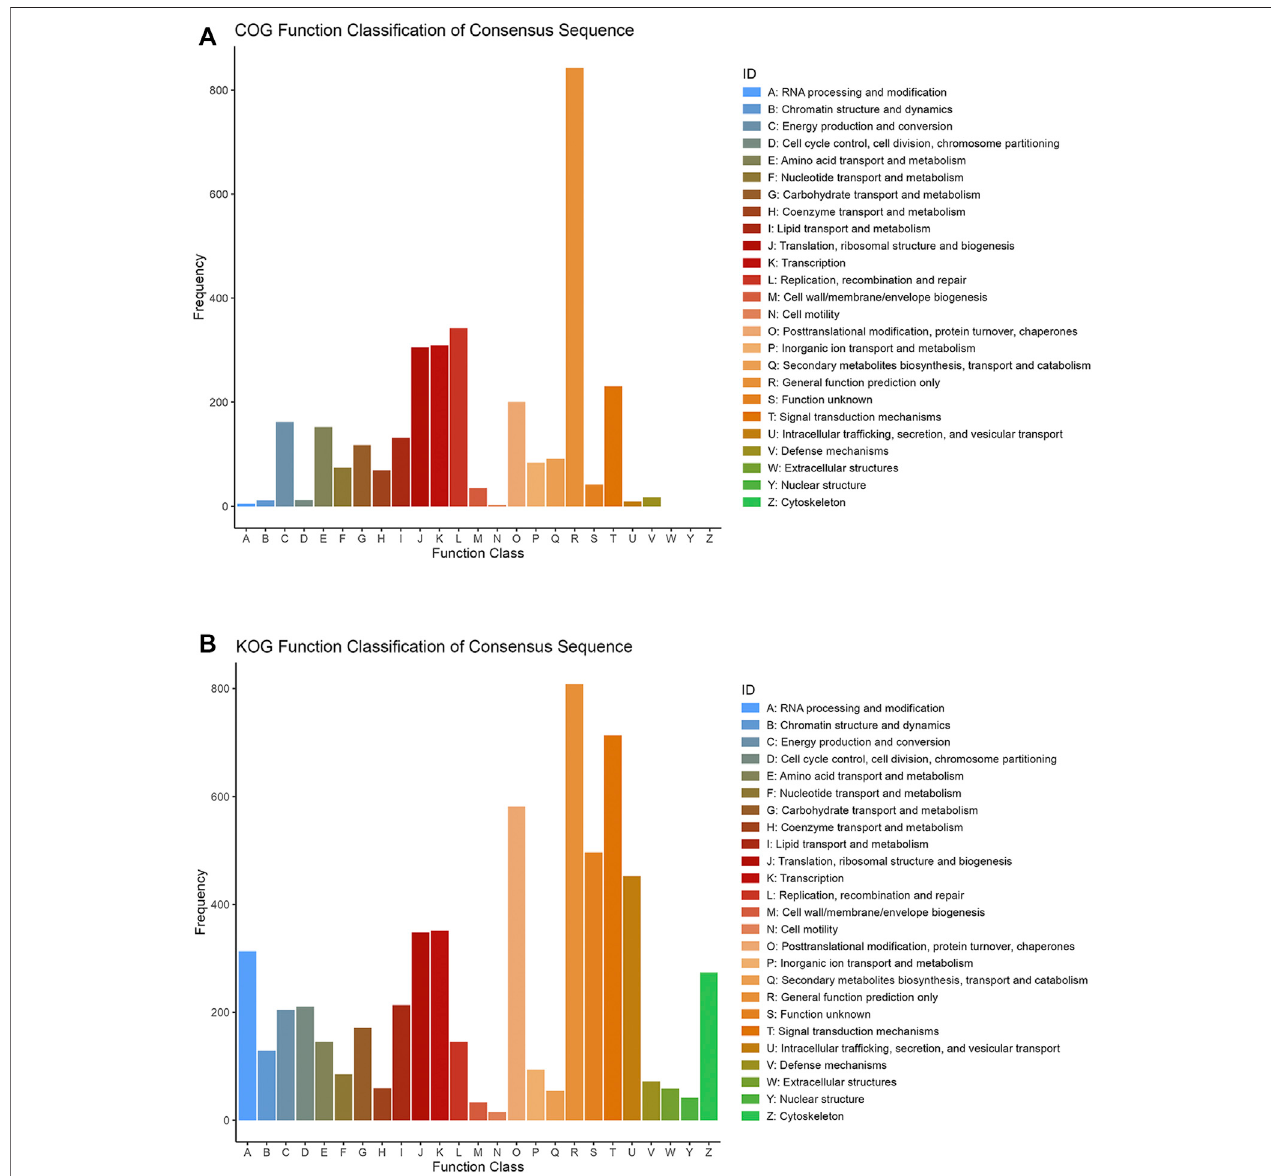
FIGURE 2 | COG (A) and KOG (B) function classi fi cation of consensus sequence. The X axis is the classi fi cation content, and the Y axis is the number of proteins.